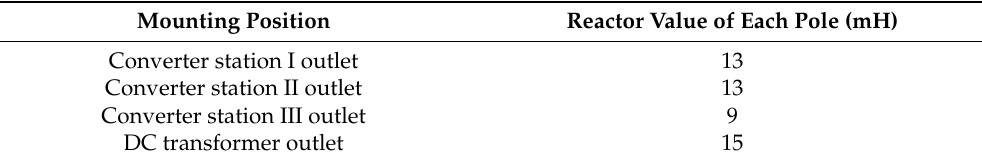
Table 9. System current limiting reactor configuration and parameters.